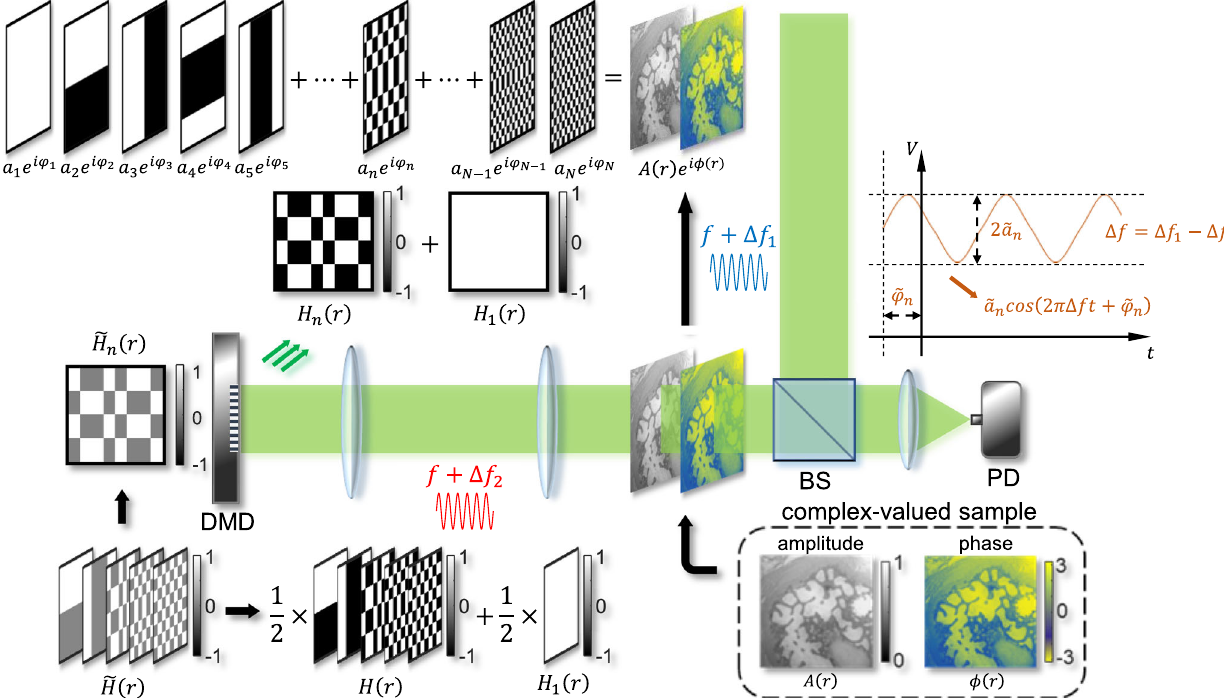
(cid:4) (cid:5) (cid:1) (cid:3) (cid:1) (cid:3) * ¼ A r * e i ϕ r * can be expressed (cid:1) (cid:3) * with corresponding coef fi cients. To retrieve these coef fi cients, one can (cid:1) (cid:3) * (with components “ 0 ” and “ 1 ” ) generated by the DMD. To implement heterodyne (cid:1) (cid:3) (cid:1) (cid:3) * * and H n r allows the reconstruction of holographic images with pure amplitude